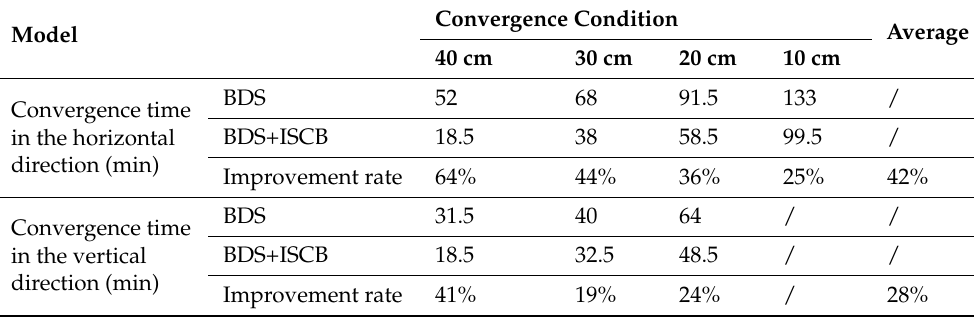
Figure 9. BDS, 2+3 joint PPP comparison with and without ISCB self, calibration. CS, convergence stage accuracy; PS, post, convergence stage accuracy. Table 5. Convergence comparisons and improvements in the different convergence conditions of BDS, 2+3 joint PPP with and without ISCB self,